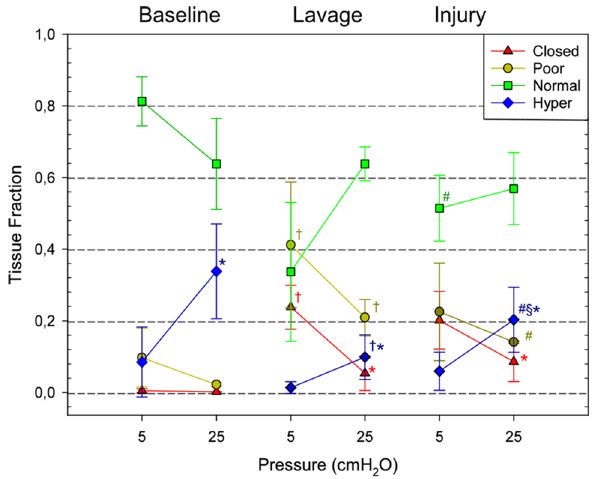
Figure 2. Average fraction of closed, poorly aerated, normally aerated and hyperinflated lung regions as a function of time and pressure at baseline, after whole lung lavage, and at the end of the injurious ventilation (n = 4). * p < 0.05 versus PEEP5 within experimental condition; † p < 0.05 versus baseline within PEEP (lavage); # p < 0.05 versus baseline within PEEP (injury); § p < 0.05 vs lavage within PEEP.